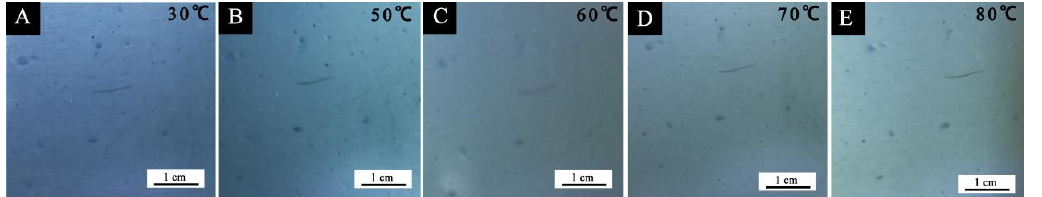
Figure 5. Discoloration of coating on a metal substrate with 10.0% thermochromic microcapsules: ( A – E ) color change during heating.